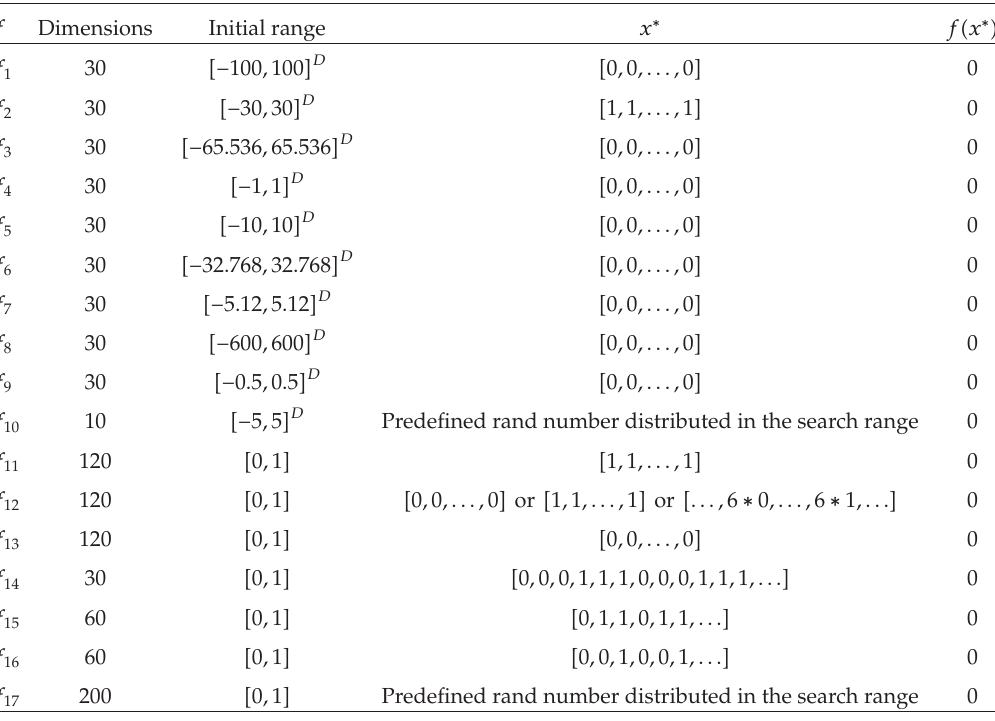
Table 6: Parameters of the test